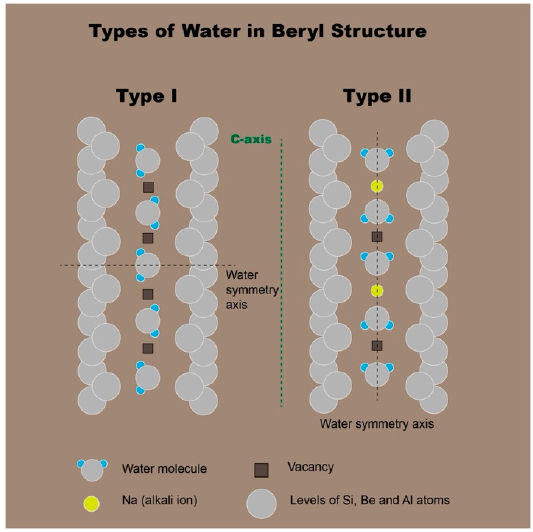
Figure 2. Type I and Type II water molecules in the channels of beryl’s structure (Updated from Wood and Nassau, 1968 [5]. Designed in Adobe Illustrator).